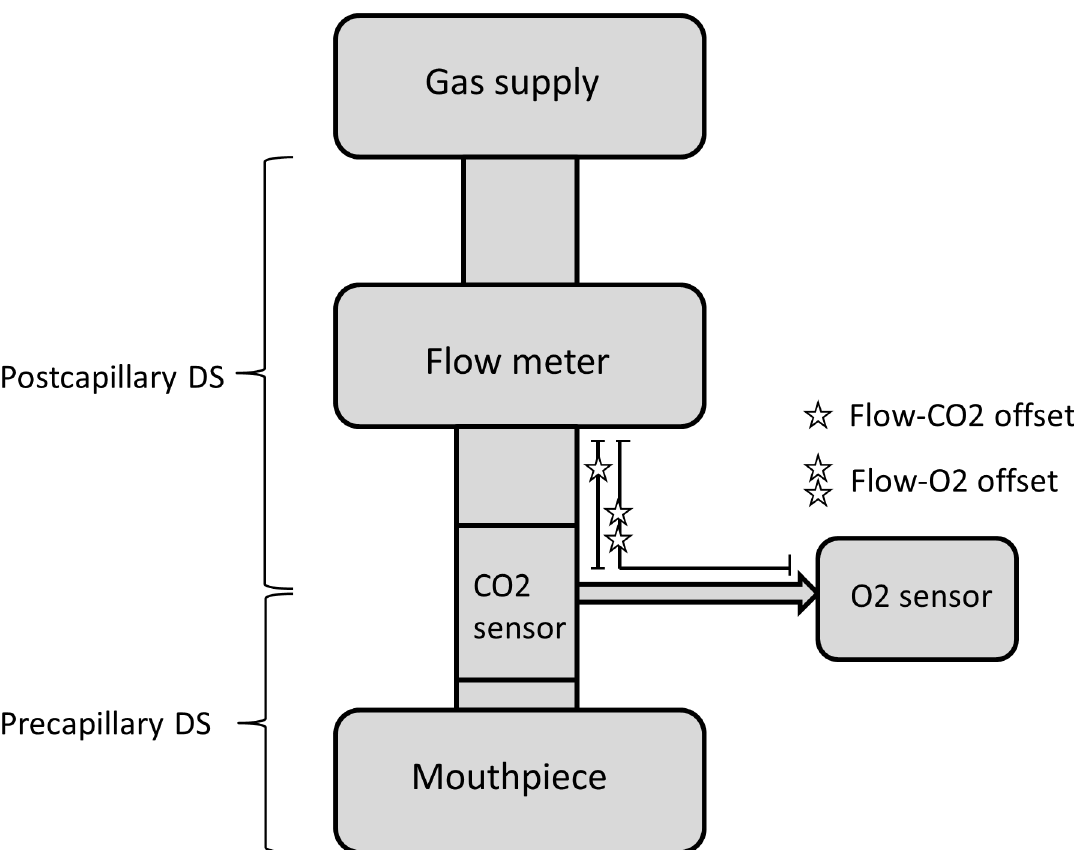
Fig 1. Schematic design of the N 2 MBW setup. The figure illustrates the patient interface and measurement points of the current nitrogen multiple-breath washout (N 2 MBW) setup device (Exhalyzer D). Flow (and derived volume) are measured by a mainstream ultrasonic flowmeter. Gas concentrations are measured by the side-stream laser O 2 sensor and the main-stream infra-red CO 2 sensor. The N 2 fraction is measured indirectly by F N2 = 1 – F O2 – F CO2 – F Argon . The gas sampling port divides pre- from post-capillary dead space. Star symbols give approximates of volume and thus delay times (off set) between gas and flow sampling points. The gas supply illustrates the open bypass; during the N 2 MBW the patient breathes 100% O 2 through the mouthpiece.